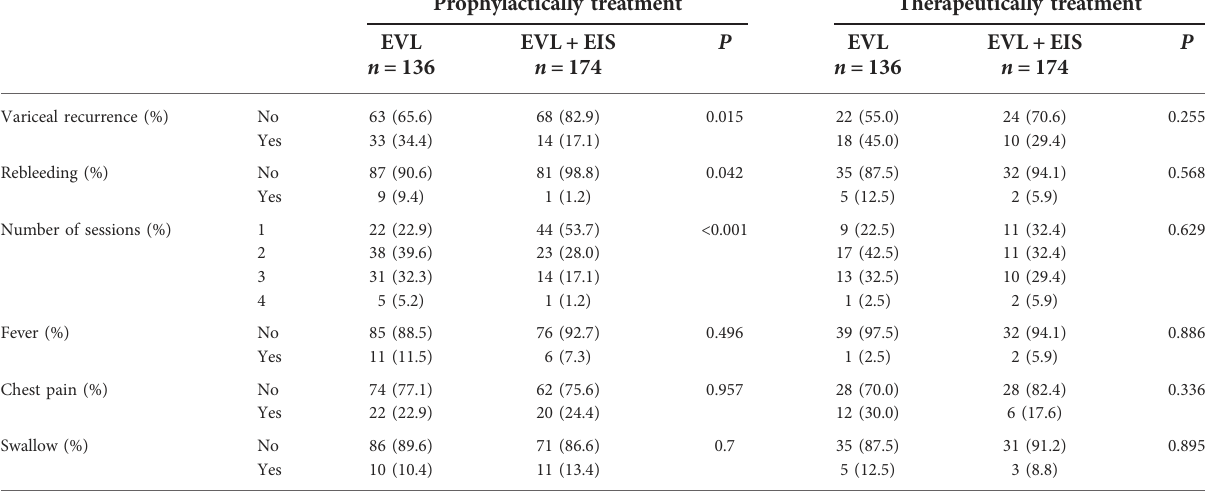
TABLE 3 Prophylactically and therapeutically endoscopic treatments in 12